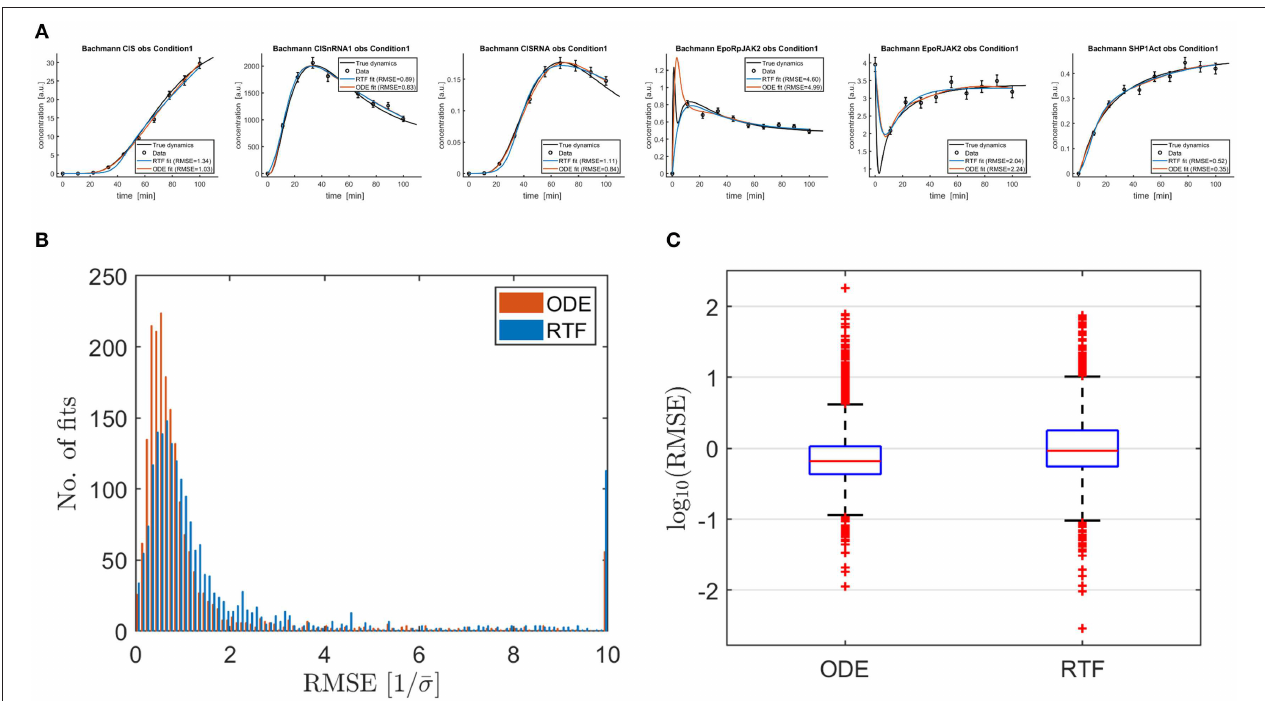
FIGURE 3 | (A) Shows six typical outcomes for fitted RTF models (blue lines) (11), (12) and ODE models (brown lines) in order to compare the outcomes of both modeling approaches for fitting of data. Fitting has been performed based on (13), (18)–(21). The black lines represent the solutions of the ODE equation models which are taken from Hass et al. [ 2] for published parameter values and presumed as true dynamics for the simulation of the data. In most cases, both approaches provide estimated curves which are close to the true dynamics and the performances coincide. Moreover, there are some examples, where either one or both approaches provide biased outcomes. (B) Shows the resulting RMSEs (14) as histograms. All values above 10 are plotted in the rightmost bin. On average, the ODE approach results in smaller RMSEs but the RTF is only slightly inferior. This qualitative outcome is confirmed by the boxplot shown in (C) . It shows that the differences between the individual fits are much larger than the average performance loss of the